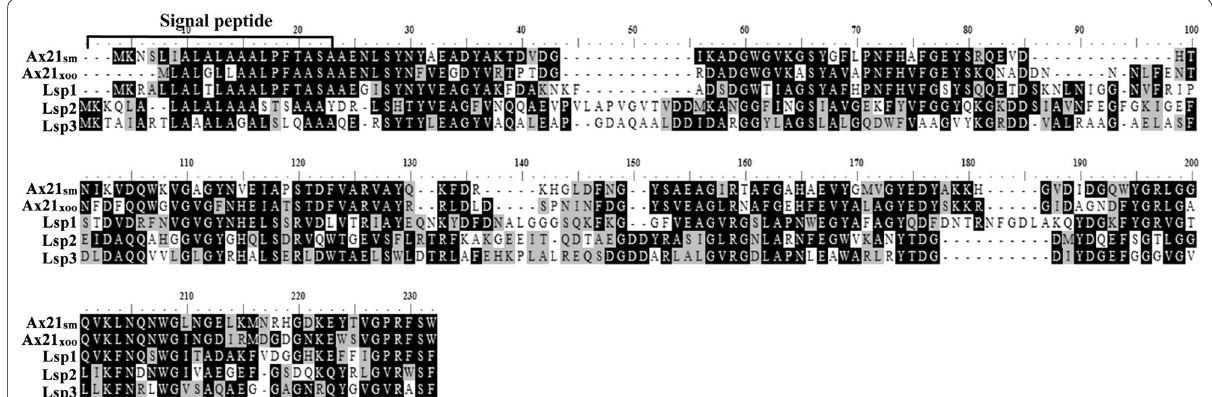
Fig. 1 Multiple sequence alignment of Lsp proteins and its homologous proteins. Ax21 Sm is Smlt0387 from Stenotrophomonas maltophilia ; Ax21 Xoo is PXO_03968 from Xanthomonas oryzae pv. oryzae ; Lsp1 (KR258786), Lsp2 (KR258787) and Lsp3 (KR258788) are the Ax21 Xoo homologous proteins identified from Lysobacter enzymogenes . The secretory signal-peptide sequence was indicated, which has been characterized as ‘MKTSLLALGLLAAL- PFAASA’ from Ax21 Xoo (Bahar et al.